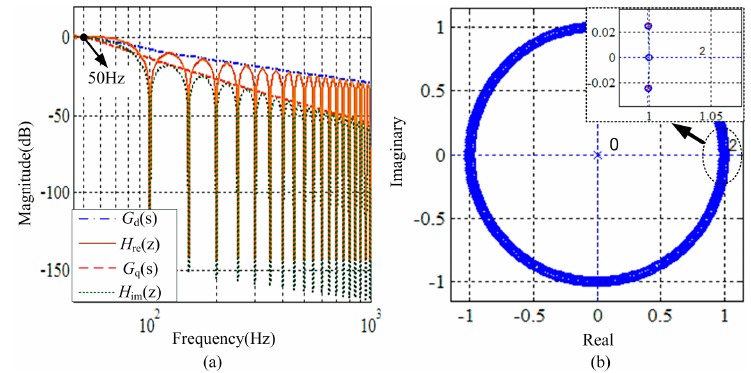
Figure 2. Frequency response and z -domain zero/pole of SGDFT when k = 1, N = 256. ( a ) Real and imaginary frequency response of SGDFT; ( b ) z -domain zero/pole.